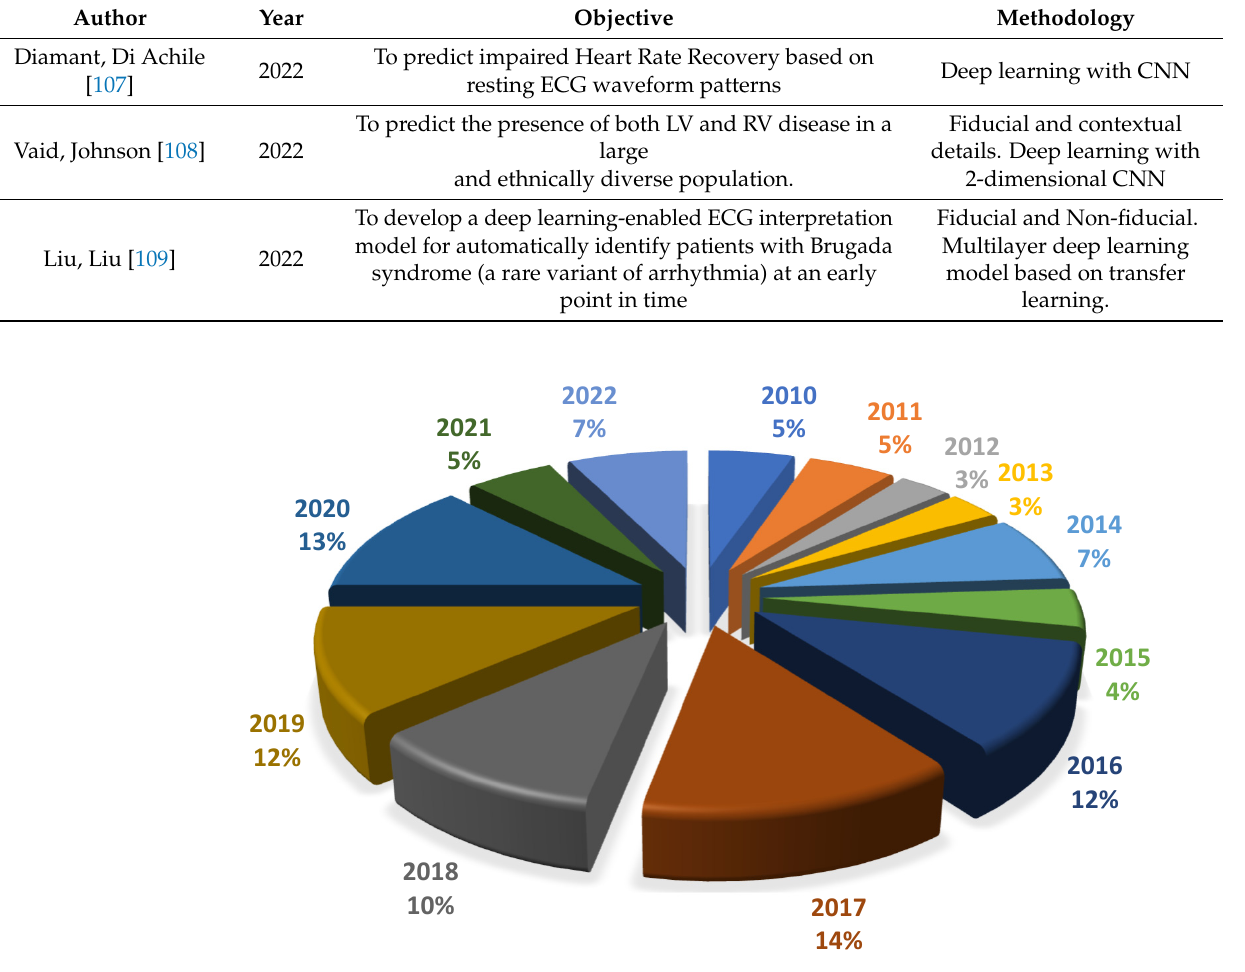
Figure 2. Percentage distribution of the studies per year.